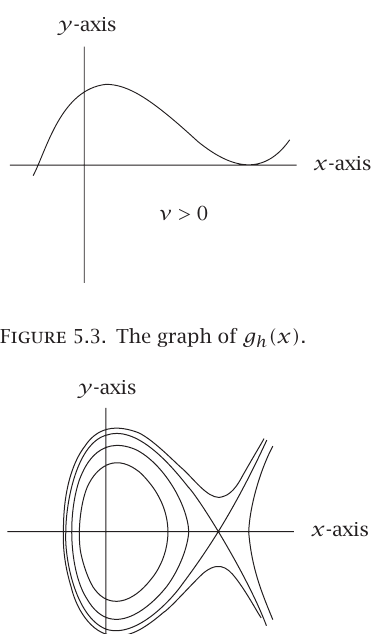
Figure 5.4 . The phase space of equation